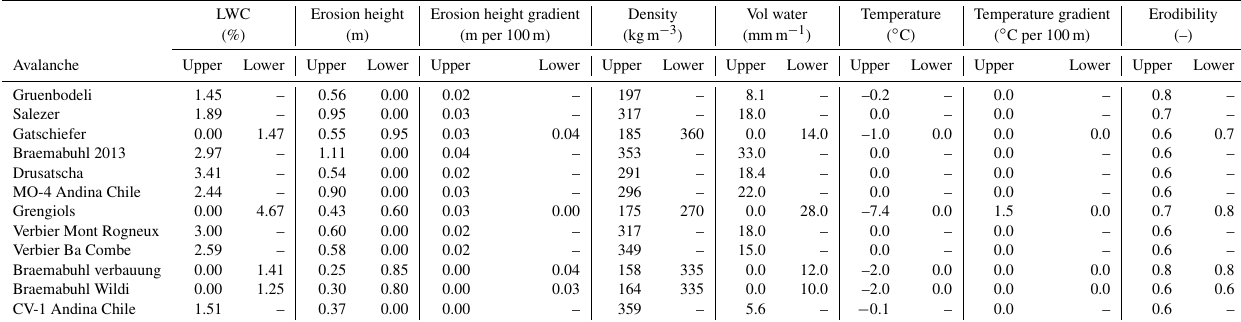
Table 3. Erosion conditions derived from the snow cover simulations for each avalanche case study. Upper and lower denotes two different erosion layers. The two-layer system was used when new snow was lying over old snow cover and both layers were part of the studied avalanche. In the case of only one layer, all the fields at the second, lower layer are set to zero. LWC Erosion height